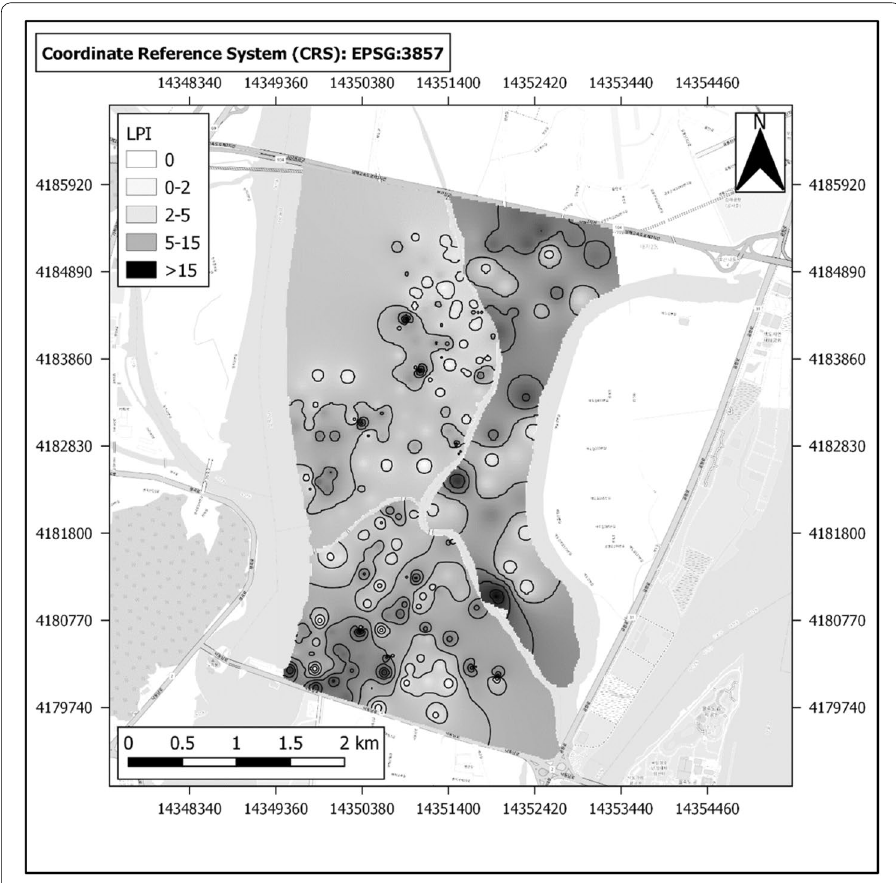
Fig. 16 Liquefaction hazard map based on DSHB [8] method for case